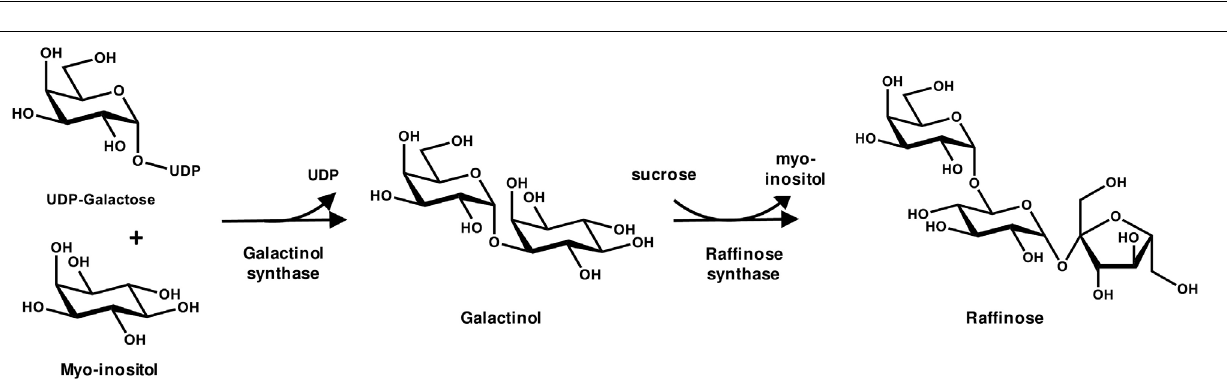
FIGURE 3 | Sugar fluxes regulating defense responses under pathogen attack. Trehalose-6-phosphate (T-6-P) is central to the metabolic switch between energy intensive processes like starch synthesis and low sugar stress conditions (when under pathogen attack or during plant defense signaling). T-6-P regulates the switch between these two conditions by regulating the multi-functional heterotrimeric stress regulator, SnRK1. SnRK1 can perceive low sugar stress and mediate defense against pathogens through post translational modification of key metabolic enzymes, activating PCD and bZIP (basic leucine zipper) mediated transcriptional reprogramming. Trehalose on the other hand can also sense pathogen stress and respond by activating defense genes and blocking the energy intensive starch biosynthesis. Sucrose regulates defense signaling both positively and negatively by activating secondary metabolite production under low sugar conditions on one hand and inhibiting SnRK1 on the other, during normal conditions. Additionally, the mitochondrial HXKs are also implicated in activating PCD and defense gene activation during pathogen attack. However, little is known if Glucose mediates the process. Thus, the components of signalling pathway of sugars (like sucrose, glucose and trehalose) that maintains the balance between stress conditions and homeostatsis are yet to be discovered and are indicated by “?” in the figure.